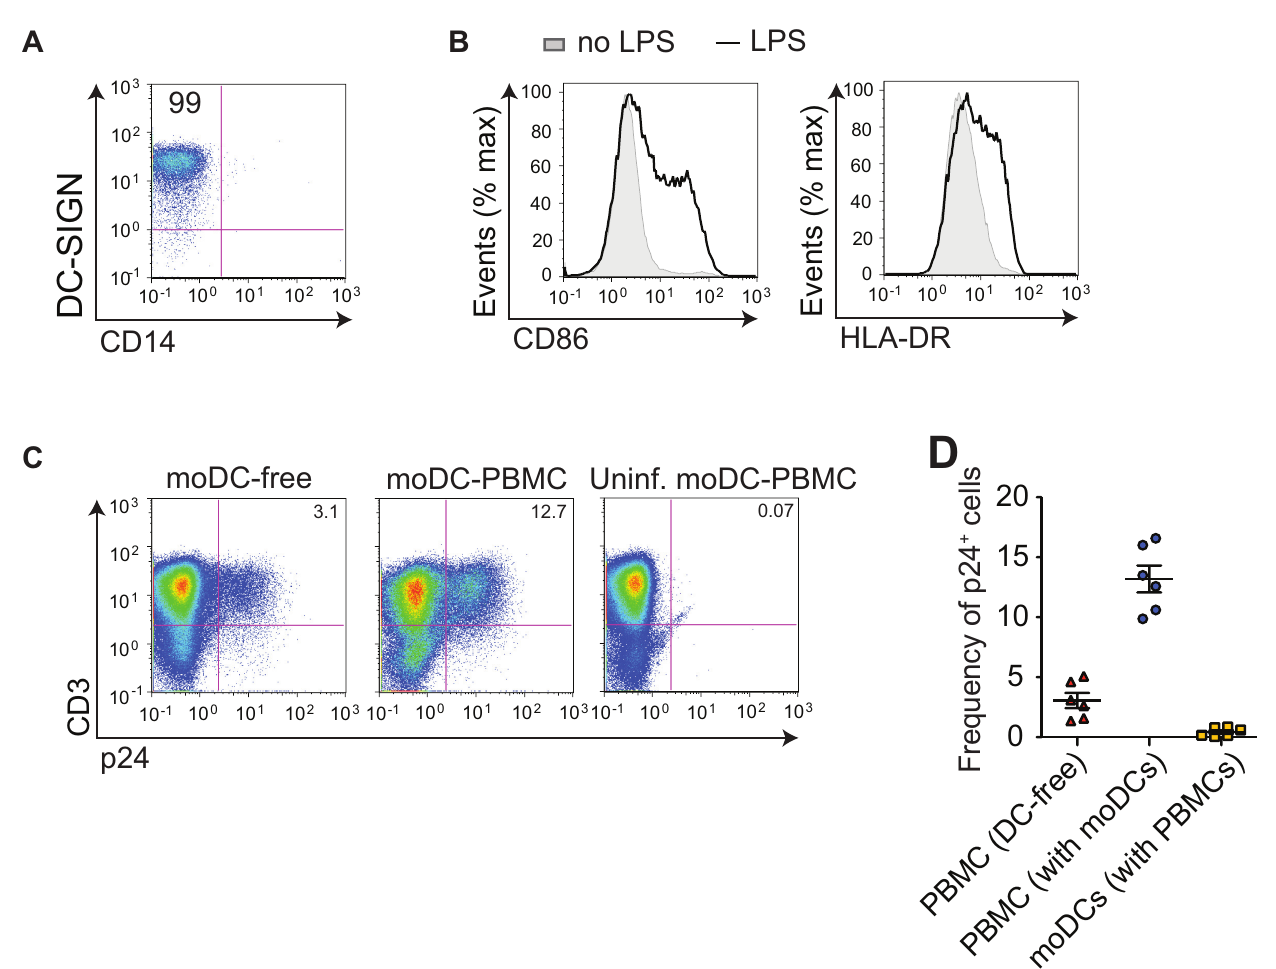
Fig 1. moDCs significantly amplify PBMC infection. ( A , B ) moDCs were treated with LPS and analyzed by flow cytometry. FACS histogram plots showing expression of DC-SIGN and CD14. Number in the top left gate indicates percentage of CD14 - DC-SIGN + cells ( A ). FACS histogram plots showing surface expression of activation markers CD86 and HLA-DR ( B ). ( C ) Infection of PBMCs without ( left )or with DCs ( center ) was analyzed by flow cytometry. Uninfected moDC-PBMC coculture ( right ) was included as a negative control. Number in the top right gate indicates percentage of infected T cells. ( D ) Frequency of infected p24 + T cells or moDCs was measured in DC-free culture or moDC-PBMC cell coculture. Each symbol represents one donor. Mean ± s.e.m ( η = 6 donors). (cid:3)(cid:3)(cid:3) , p < 0.0001 (student’s T-test). Data is representative of two independent ( A , B ), six independent ( C ) or pooled from six independent experiments ( D